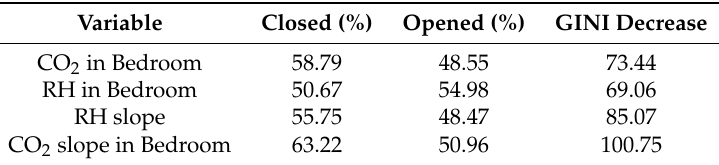
Table 5. Relevance of variables for the window model.